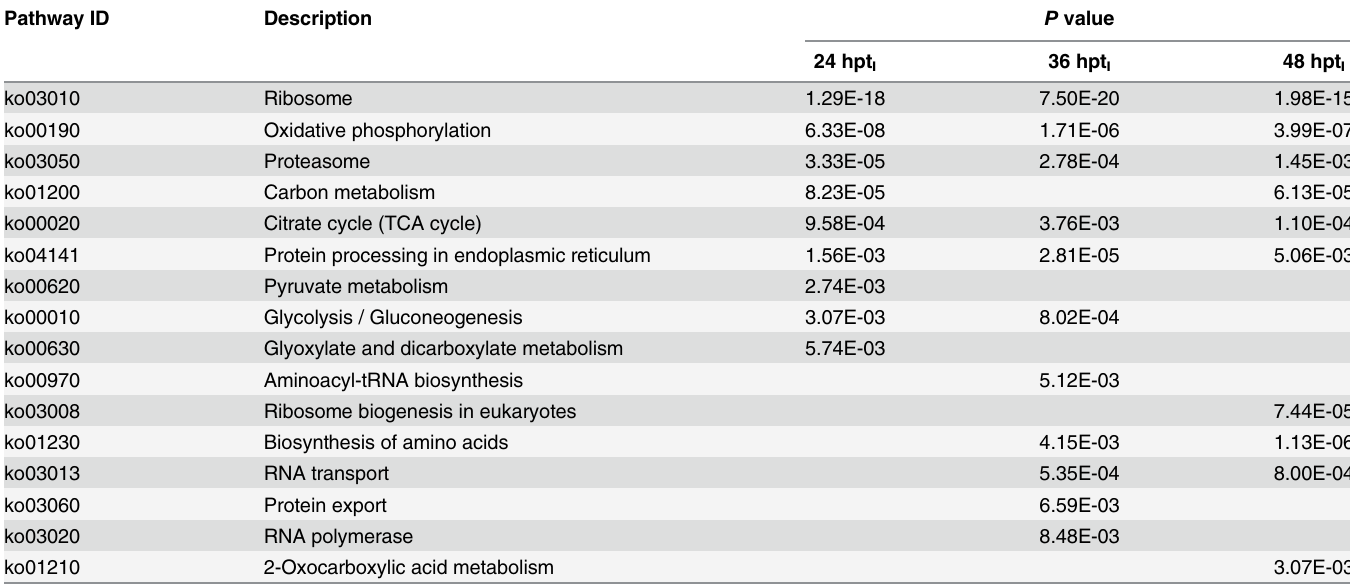
Table 3. KEGG enrichment analysis of B . bassiana